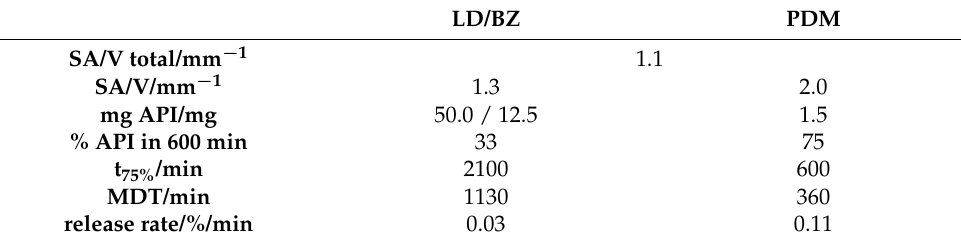
Figure 10. ( Left ): release profile of PP3; modified basket apparatus, 1000 mL 0.1 N HCl, 50 rpm, 37.0 ± 0.5 °C, x ± s; n = 3. ( Right ): Image of PP3: red: PDM-PVA, blue: LD/BZ-EVA. Table 9. Structure and release properties of PP3.